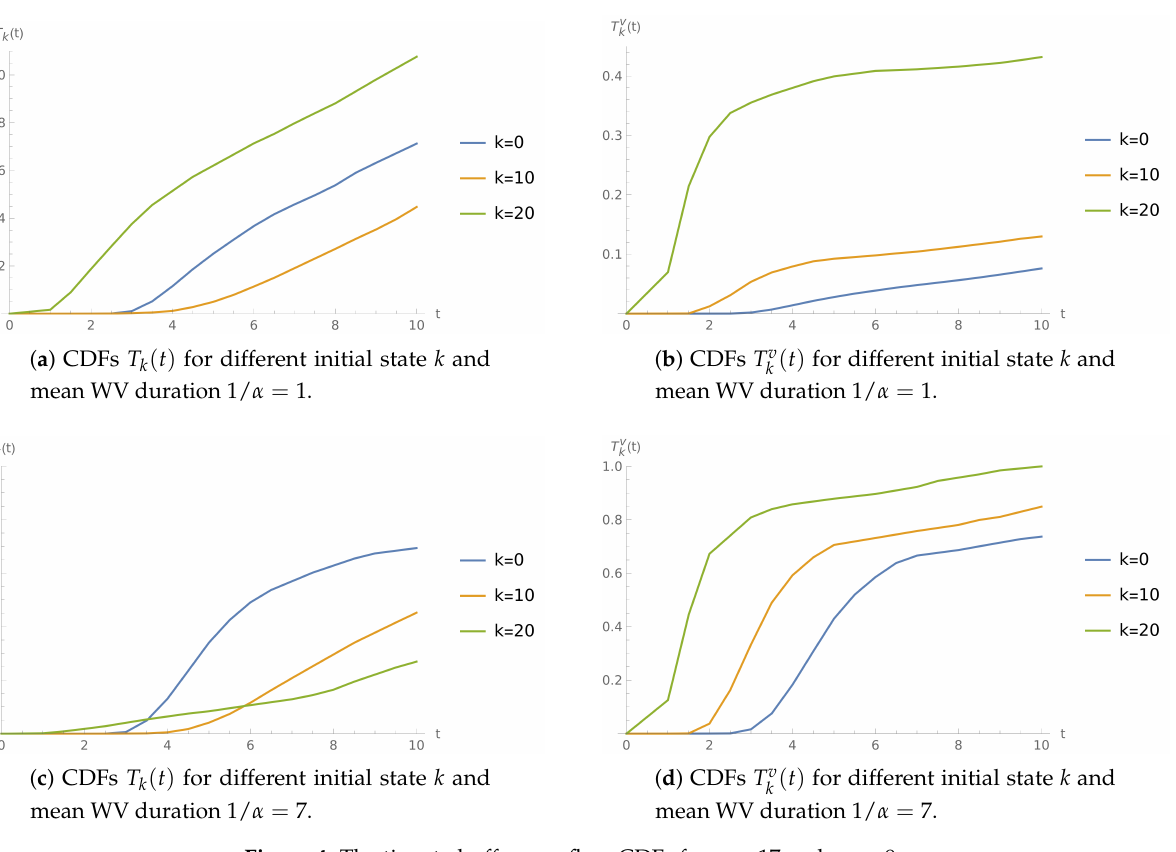
Figure 4. The time to buffer overflow CDFs for µ = 17 and µ v =